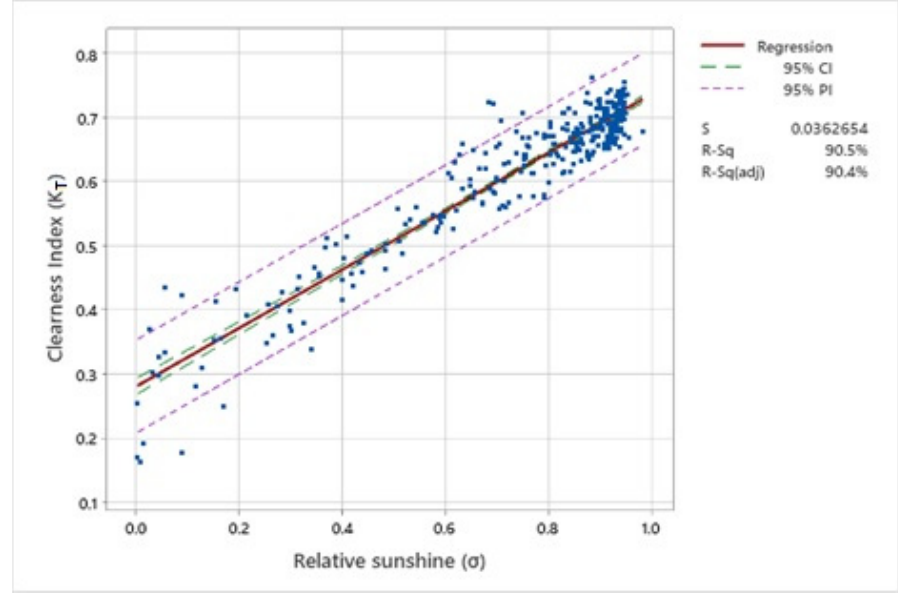
Figure 13. Linear relationship between K T and σ . K T = 0.281 + 0.455 ∗ σ , R 2 = 0.904.